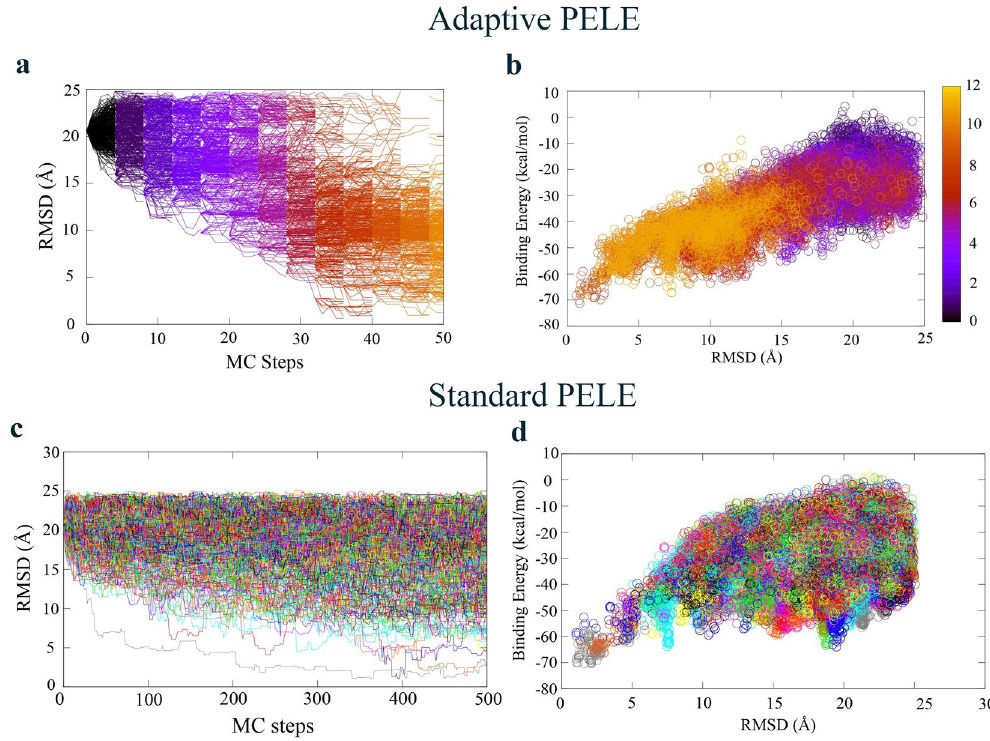
Figure 2. Energy landscape exploration of B-GPCR with 512 different explorers. ( a,b ) The RMSD variation along MC steps and the binding energy against the RMSD for the adaptive results. Each color code corresponds to a different epoch number, for a total of 12 adaptive iterations. ( c,d ) Analogous plots for the standard executions. Each color corresponds to a different trajectory (performed in a different computing core). Notice the change in scale in the X-axis between ( a ) and ( c